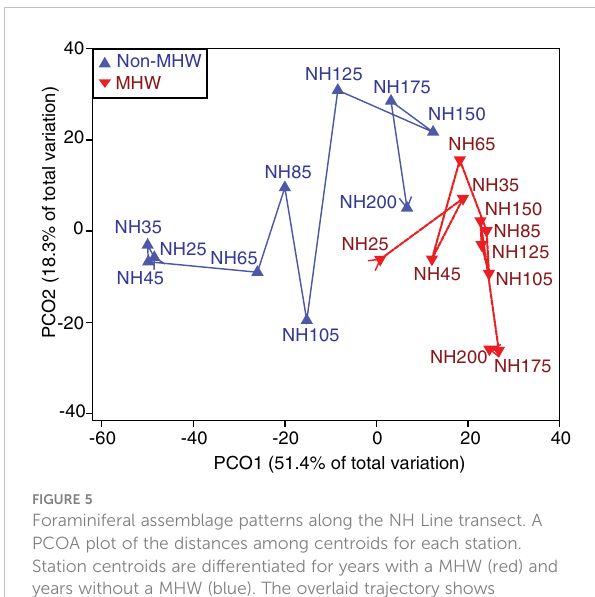
FIGURE 5 Foraminiferal assemblage patterns along the NH Line transect. A PCOA plot of the distances among centroids for each station. Station centroids are differentiated for years with a MHW (red) and years without a MHW (blue). The overlaid trajectory shows increasing distance offshore from NH25 increasing to NH200.